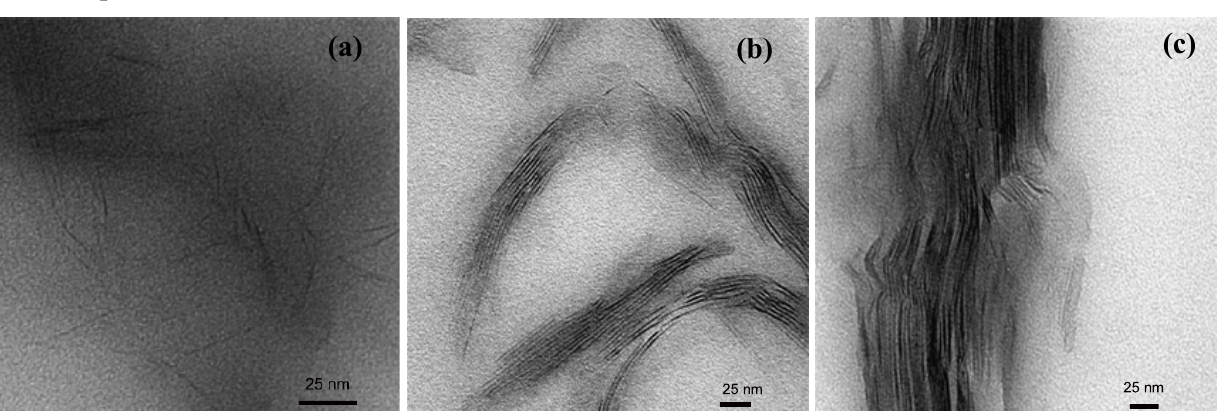
Figure 8. TEM micrographs indicating various possible morphologies in the composites as function of the filler distribution: (a) exfoliated, (b) intercalated and (c) unintercalated. Reproduced from reference